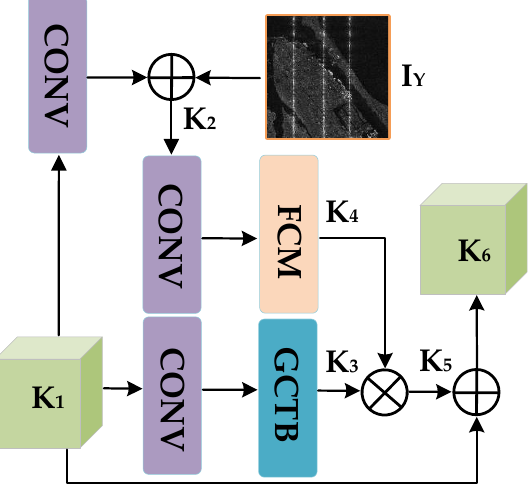
Figure 5. The overall structure of ICN. Where the black arrows indicate the transfer information stream. ⊕ and ⊗ denote feature fusion and elements multiplication,